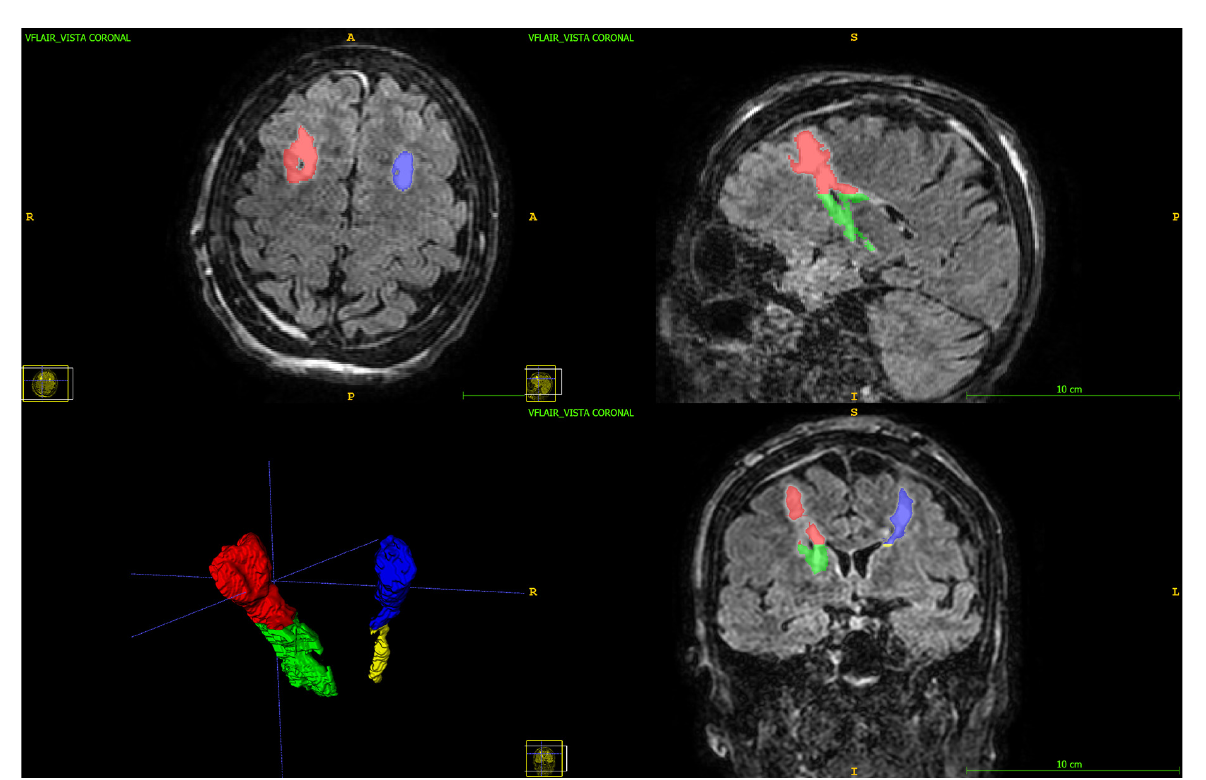
FIGURE1 3D FLAIR image with multiplanar reconstruction in axial, coronal, and sagittal planes. The subcortical edema (red and blue) and the basal edema (green and yellow) Volumes of Interest are displayed.